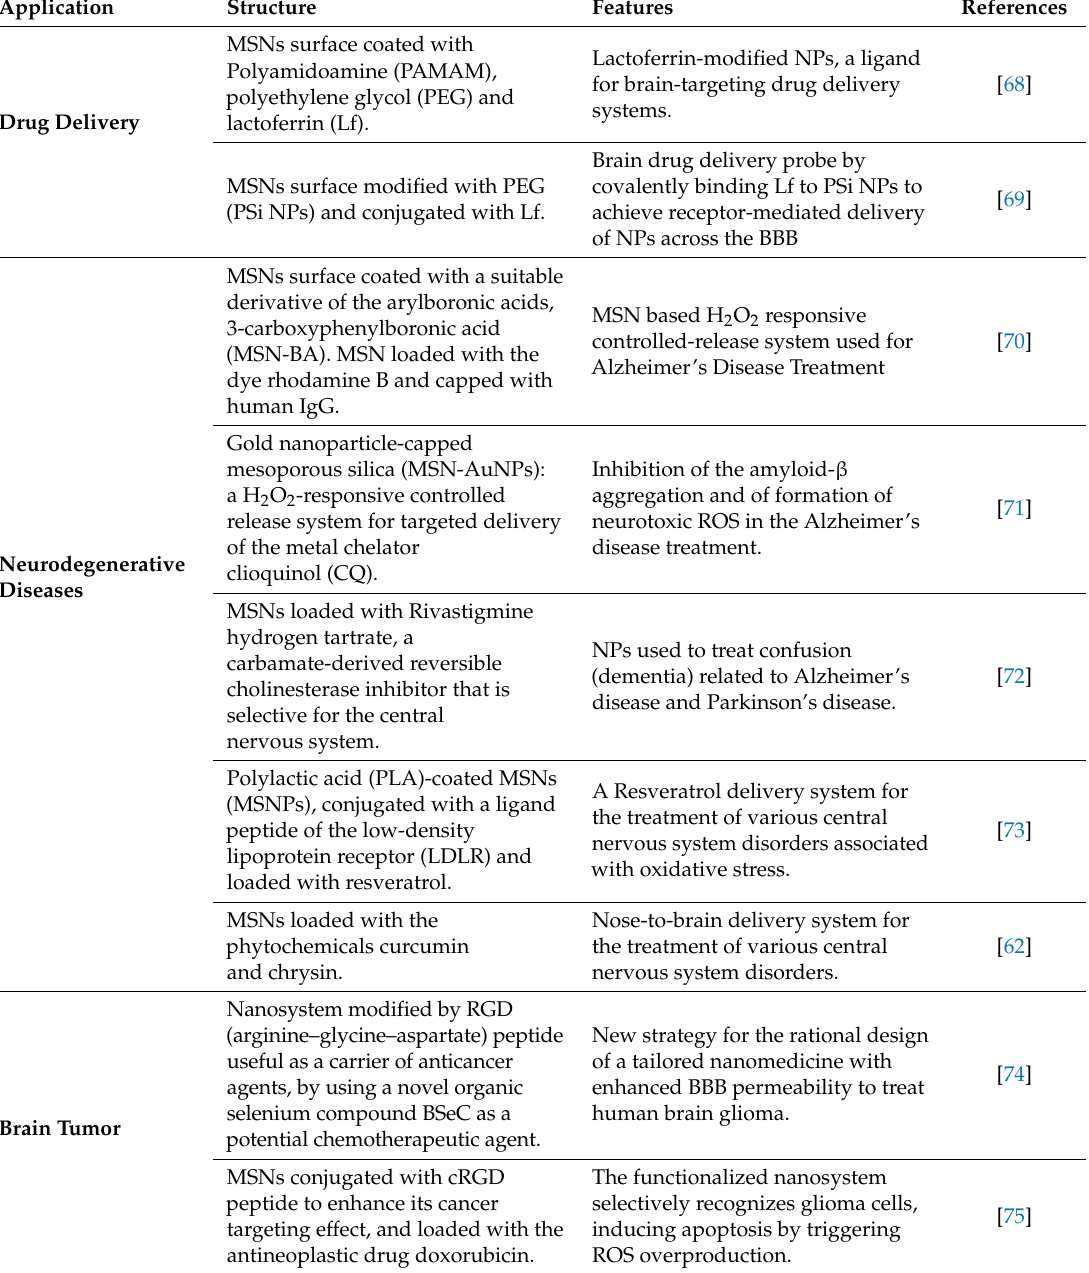
Table 2. Recent advances on MSNs as brain drug delivery